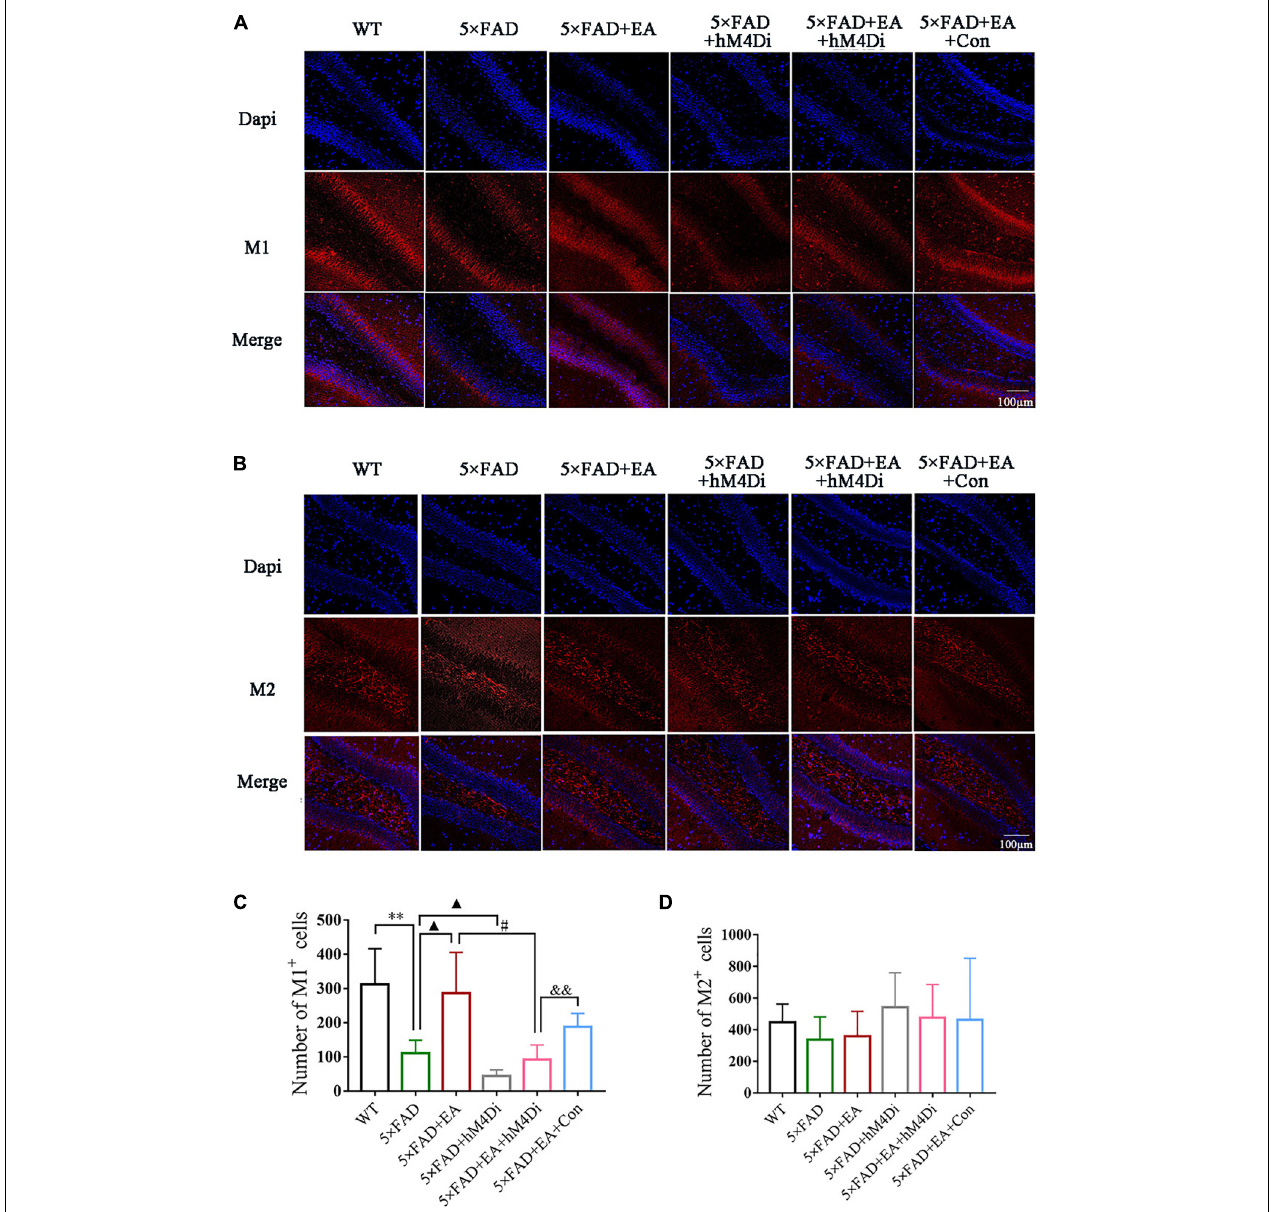
FIGURE 12 | Electro-acupuncture (EA) treatment activates the MS/VDB-DG cholinergic neural circuit regulating M1 receptors in 5 × FAD mice. Representative images of M1 receptors (A) and M2 receptors (B) in the DG. Groups were subjected to immunofluorescence labeling with Dapi (Blue), M1 or M2 (red) staining. Scale bar = 100 µ m. Quantified M1 positive cells (C) and M2 positive cells (D) . Data are represented as mean ± SD, n = 4/group ( ∗∗ p < 0.01 vs WT group; (cid:78) p < 0.05 vs 5 × FAD group; # p < 0.05 vs 5 × FAD + EA group; && p < 0.01 vs 5 × FAD + EA + hM4Di